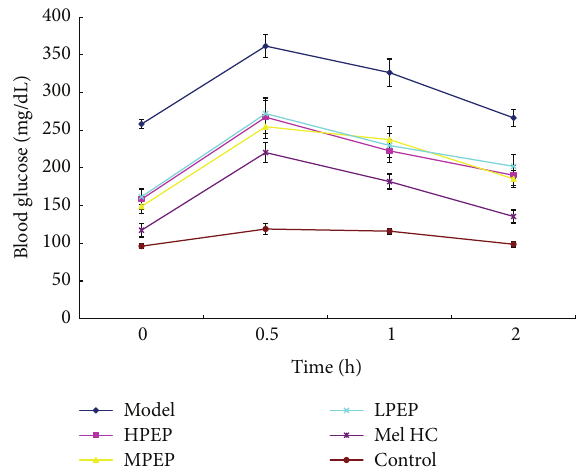
Figure 2: The effect of PEP on OGTT in DM rats. A DM model was established by feeding rats a high-fat diet and injecting them with a low dose of STZ. After the model was established, PEP (0, 150, 300, and 600 mg/kg) was administered intragastrically as an intervention for 28 d ( 𝑛 = 10 rats). Subsequently, the OGTT was performed. Control: control group; Model: model group; Mel HC: metformin HC group; LPEP: low-dose PEP group; MPEP: medium-dose PEP group; HPEP: high-dose PEP group.